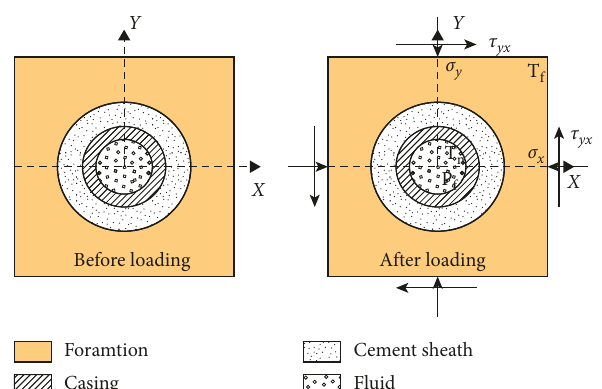
f ; inner boundary temperature, T n ; normal stress, σ x and